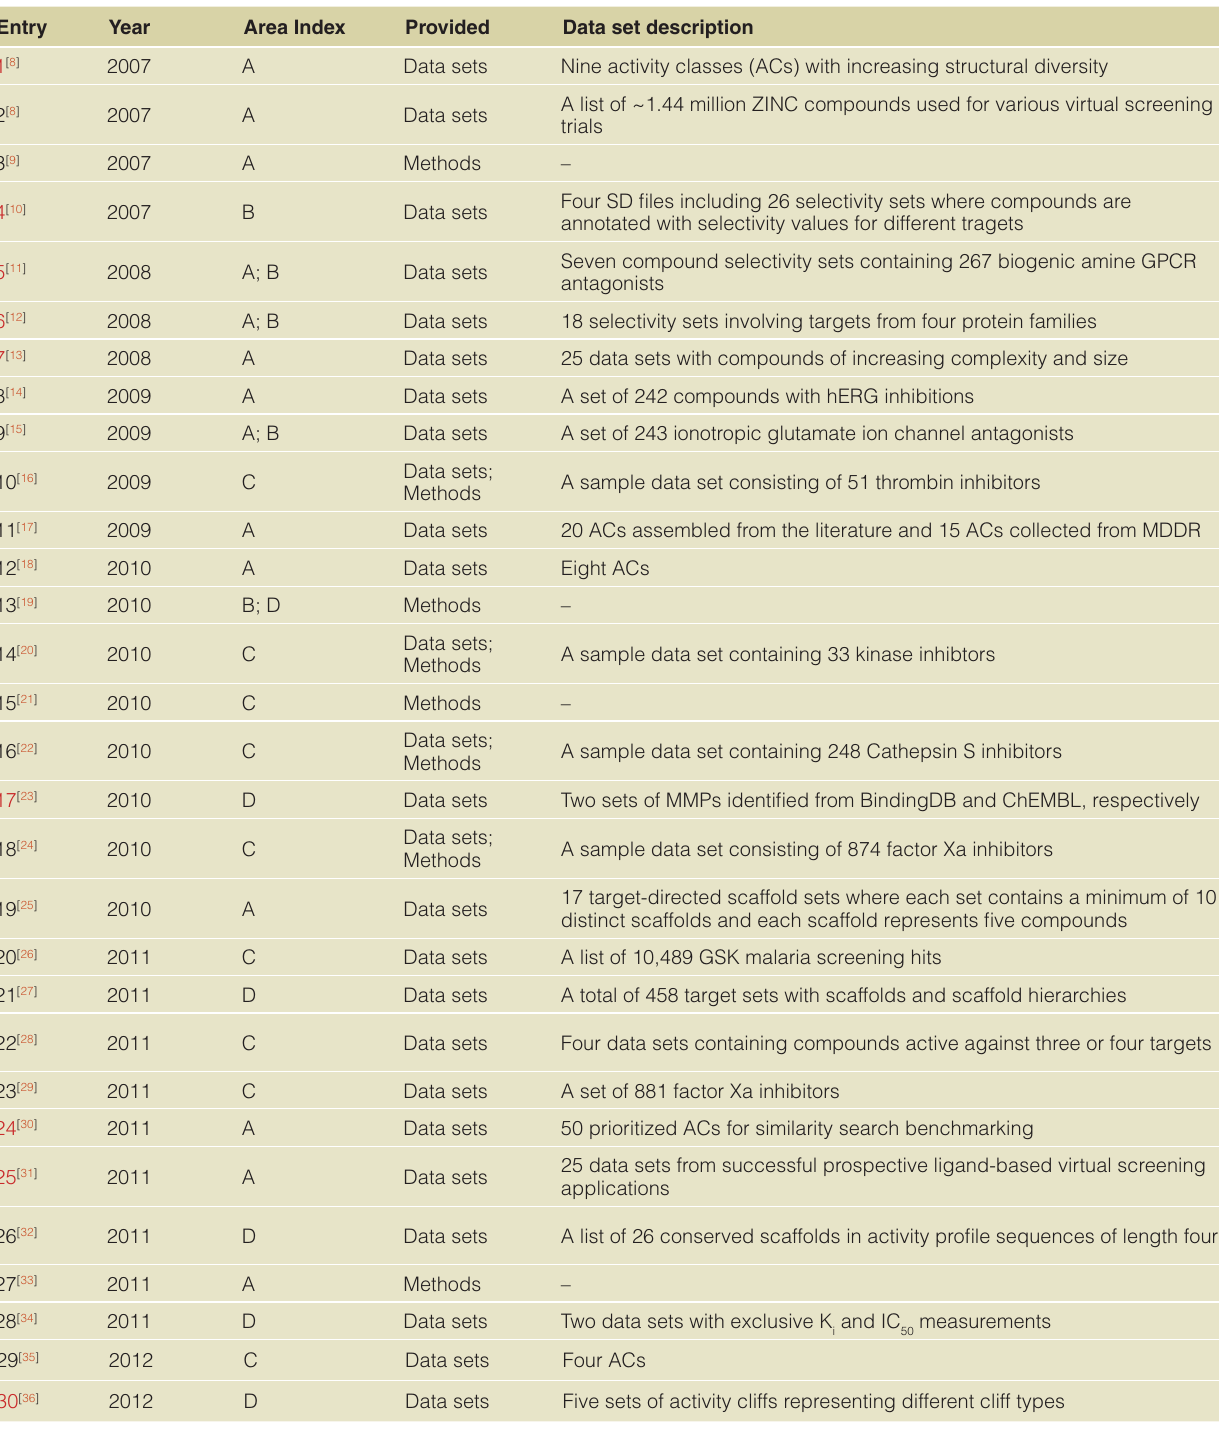
Table 1. Publicly available data sets and programs. A list of 30 entries providing data sets and/or methods/programs is shown. For each entry, research area indices are assigned as described in the text, i.e. area ‘A’ indicates virtual screening (similarity searching), fingerprint engineering and machine learning; area ‘B’ represents molecular selectivity analysis, area ‘C’ SAR visualization, and area ‘D’ structure- activity or -selectivity relationship-oriented data mining. In addition, publication information is given. For compound data sets, short descriptions are provided. Selected compound data sets are highlighted in red and discussed in the